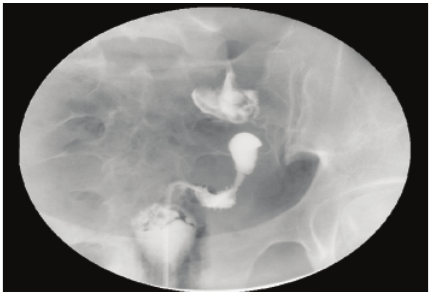
Figure 2: Hysterosalpingogram with unicornuate uterus pushed to the left.